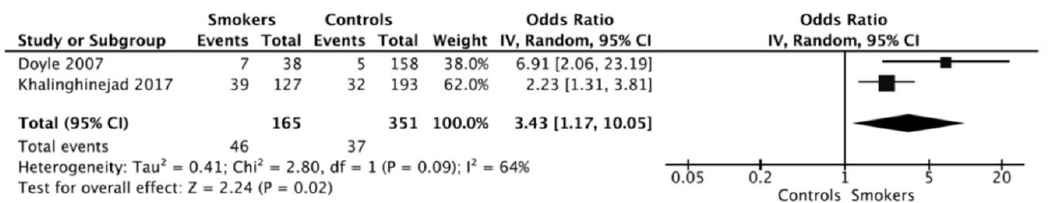
Figure 3. Forest plot of ORs and 95% confidence limits (CL) for the comparison of smokers and healthy control subjects regarding the frequency of extracted root-filled teeth (RFT). Overall estimate is based on data from the two studies. Black squares represent the point estimate of the odds ratio and have areas proportional to study size. Lines represent 95% confidence intervals. The diamond shows the summary statistic for the two studies. The solid line indicates an odds ratio of 1.0, and the dashed line indicates the overall odds ratio. OR: odds ratio; LCL: lower confidence level; UCL: upper confidence level.